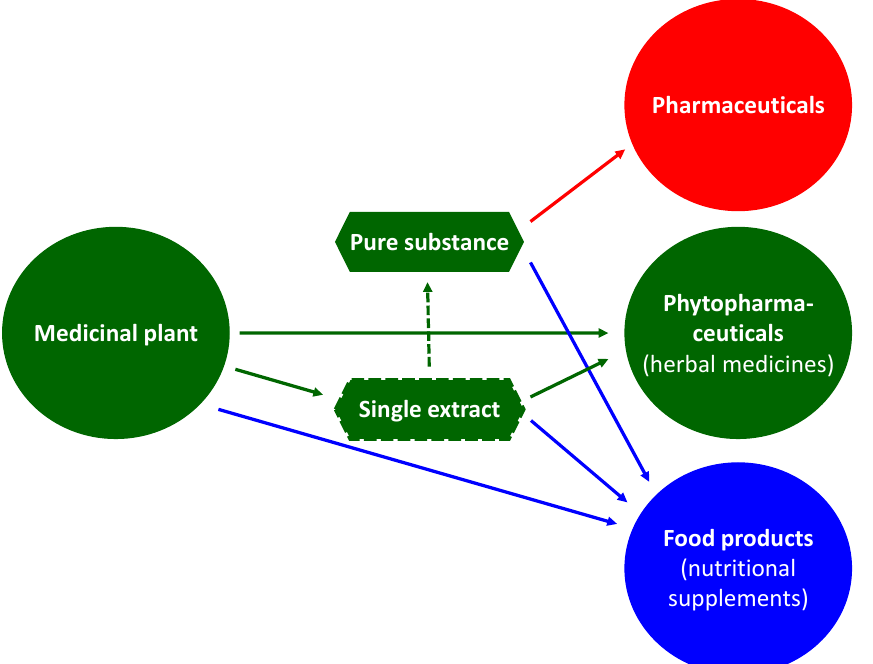
Figure 2. Plant parts can be used unmodified, as an extract or as an isolated pure substance for medic- inal products, phytopharmaceuticals (herbal medicines), or foodstuffs (food supplements). Pharma- ceuticals use pure substances as active ingredients, and phytopharmaceuticals (herbal medicines) contain plant parts or their extracts. Components of foodstuffs can be plant parts, extracts, or pure